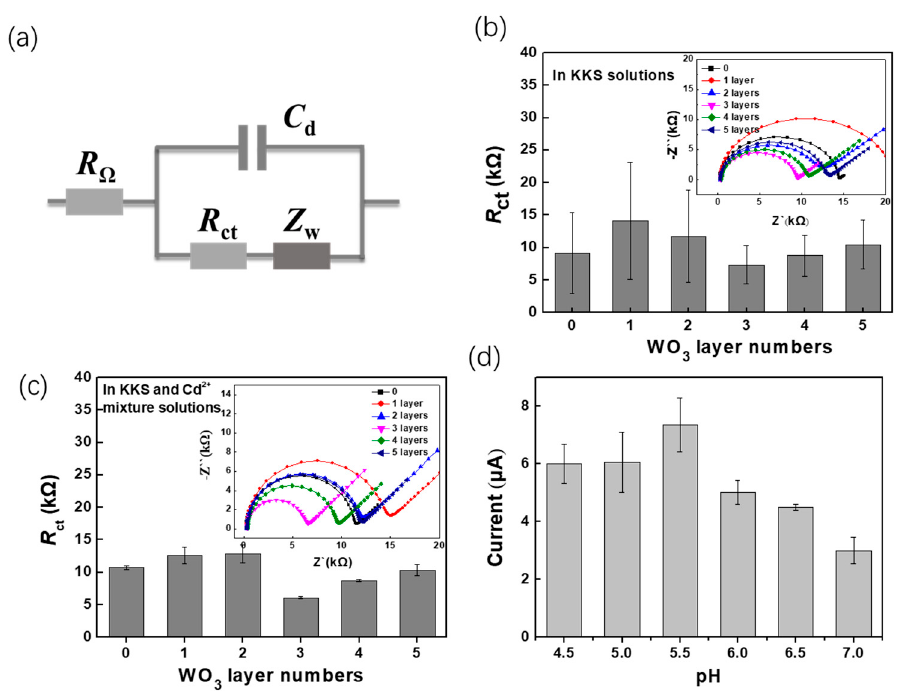
Figure 4. Optimization of WO 3 -modified electrodes. ( a ) The equivalent circuit of the electrochemical system; ( b ) The EIS (inset) and R ct of the modified electrode with different numbers of layers of WO 3 nanocrystals in the KKS solution; ( c ) The EIS (inset) and R ct of the modified electrode with different numbers of layers of WO 3 nanocrystals in the KKS and Cd 2+ mixture solution; ( d ) Dissolution peak currents of WO 3 -modified electrodes in Cd 2+ solutions with different pH values.